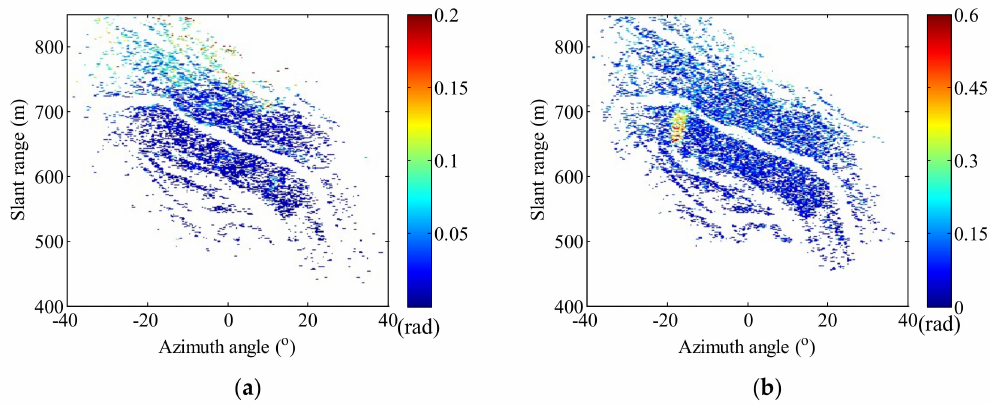
Figure 20. Phase deviation maps after the APC with the improved method: ( a ) Group A and ( b ) Group